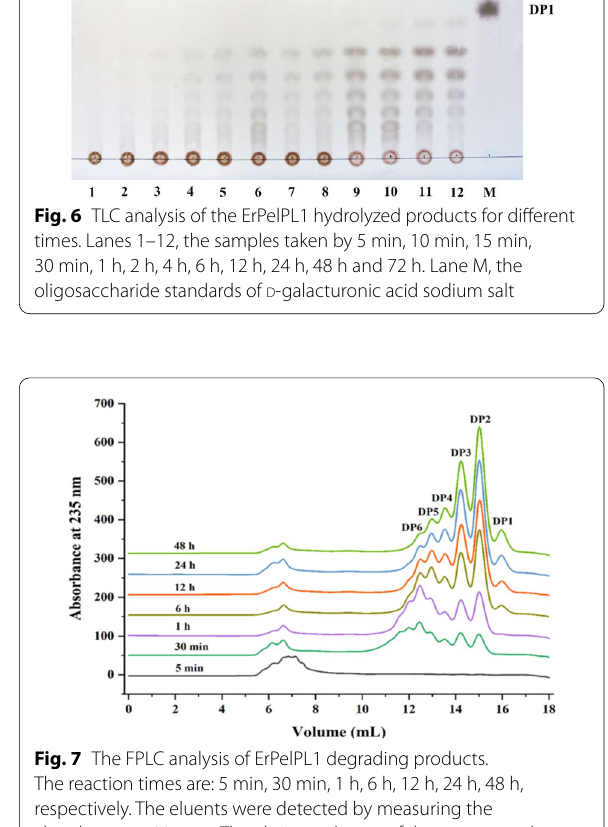
1–6) represents unsaturated oligosaccharides with DP of =